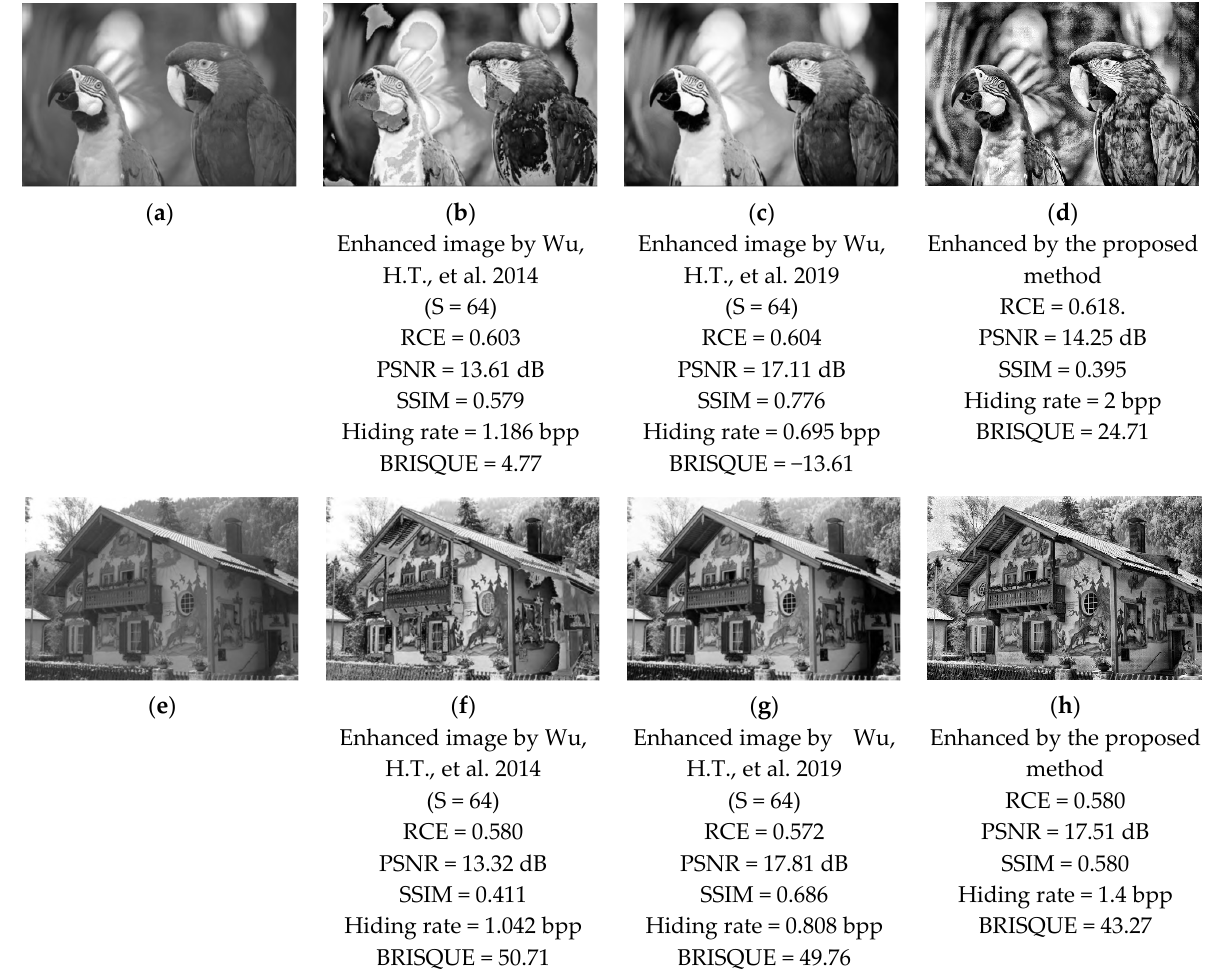
Figure 17. Two original images of USC-SIP dataset: ( a ) parrots and ( e ) house. Enhanced images obtained by algorithms in ( b , f ) [21], ( c , g ) [31], and ( d , h ) the present proposal.